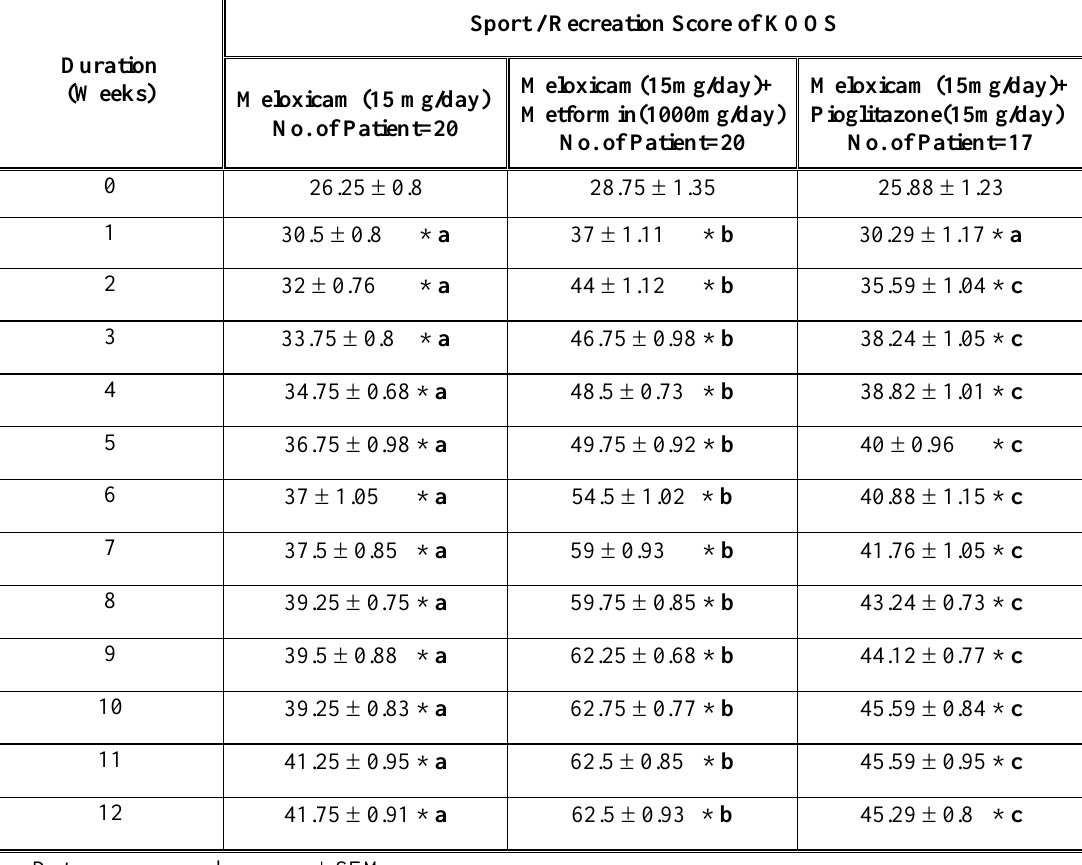
Table (4): Effects of treatment with meloxicam alone, combination of meloxicam + metformin and, meloxicam + pioglitazone on Sport/Recreation score in osteoarthritic